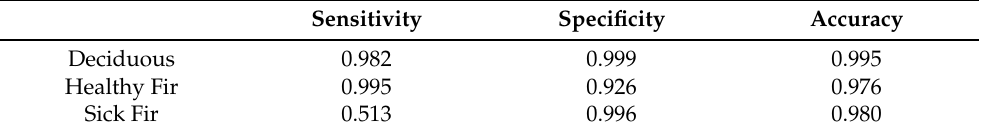
Table 3. Sensitivity, Specificity and Accuracy values for the classification of treetop patches according to